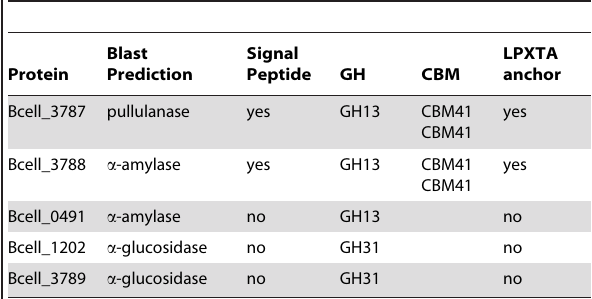
Table 7. Annotated Starch-degrading Enzymes.